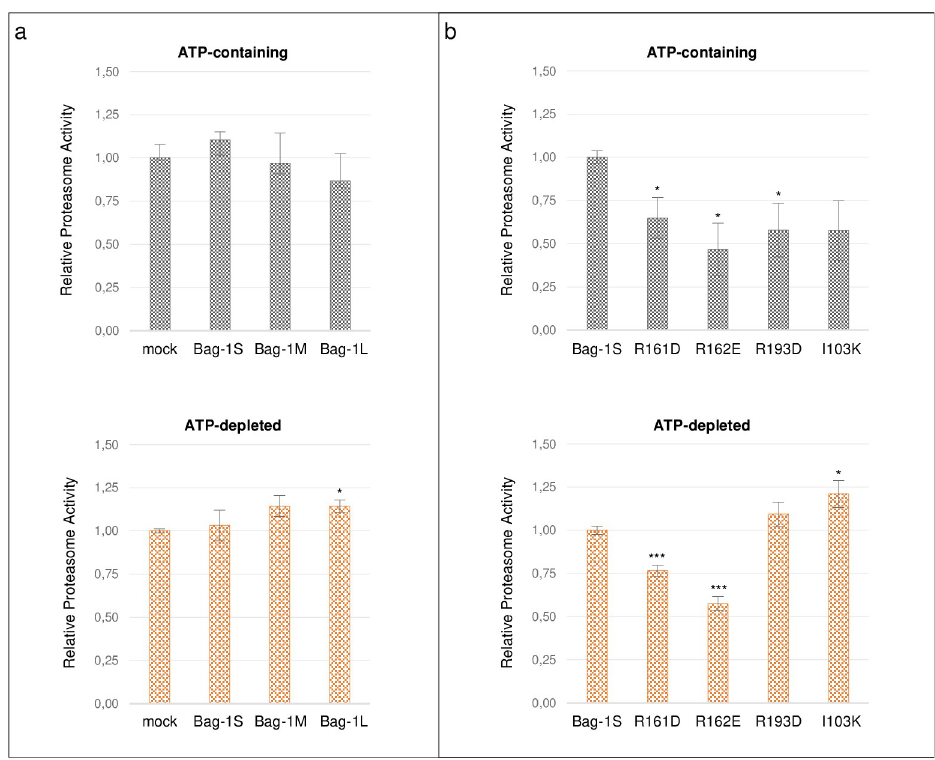
Fig 6. Mutations on BAG and UbL domains affect proteasomal activity. Proteasome activity was measured by the fluorescence of released MCA in protein extracts from MCF-7 cells after transfection with a . Bag-1 isoforms and mock vector, and b . Bag-1S mutants and wild-type Bag-1S. Proteasome activity was measured under ATP-containing (grey) and ATP-depleted (orange) conditions. Significant differences were determined by t-test.